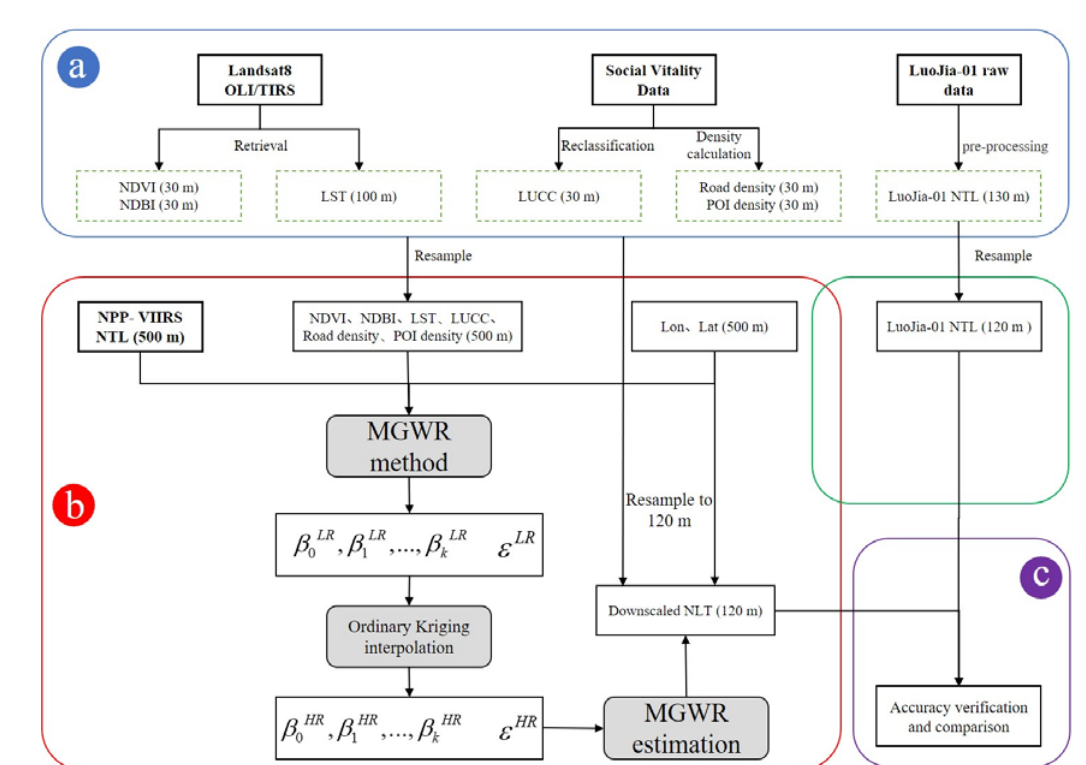
Figure 2. The proposed methodology for spatial downscaling of NTL data using MGWR.